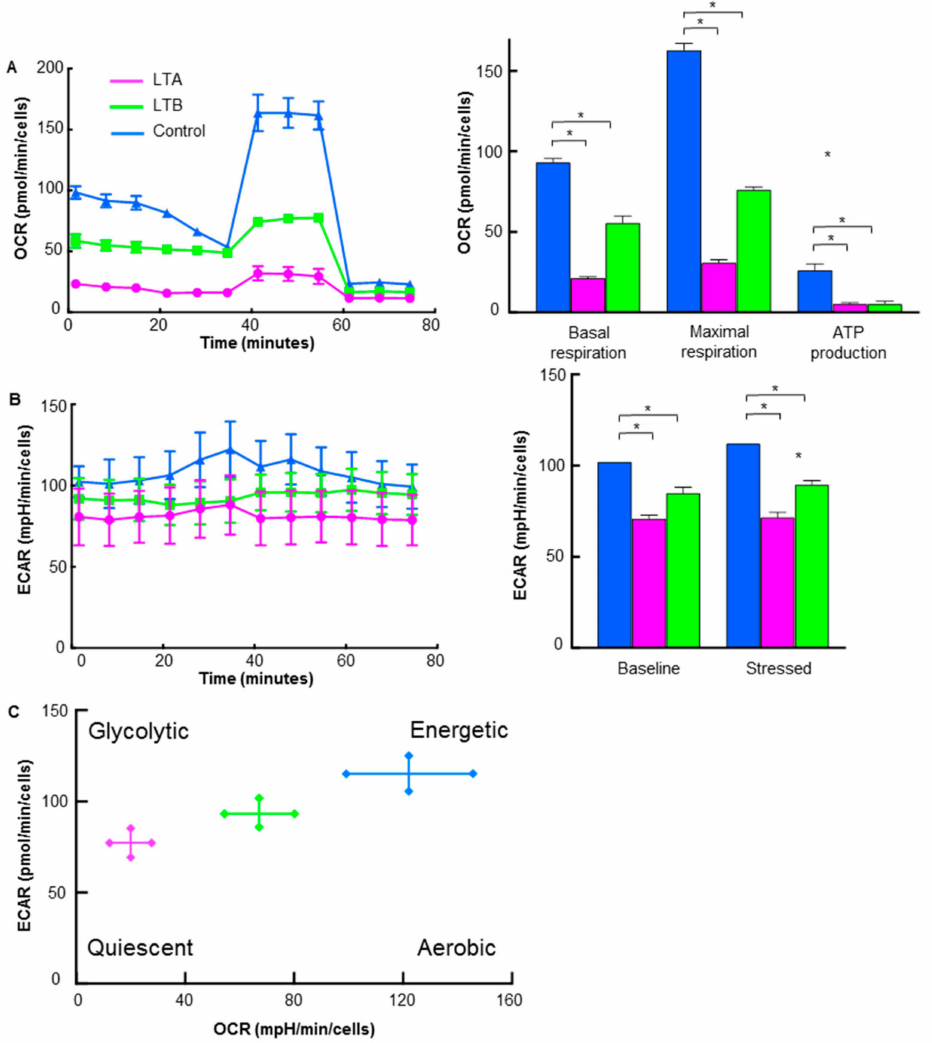
Figure 6. Energy metabolism in GEM-resistant PDA cells. Flux analysis of LTA and LTB cells without CoCl 2 or GEM treatment. ( A ) OCR (left), basal respiration, maximum respiration, and ATP production (right). ( B ) Glycolytic activity (ECAR; left), baseline ECAR, and stressed ECAR (right). ( C ) Energy phenotypic profiles. ( A – C ) Cells were cultured without GEM and/or CoCl 2 treatment. Error bars indicate standard error from three trials. * p < 0.05. Statistical significance was calculated using ordinary analysis of variance. GEM, gemcitabine; PDA, pancreatic ductal adenocarcinoma; LTA, MIA PaCa-2 long treatment A; LTB, MIA PaCa-2 long treatment B; OCR, oxygen consumption rate; ECAR, extracellular acidification